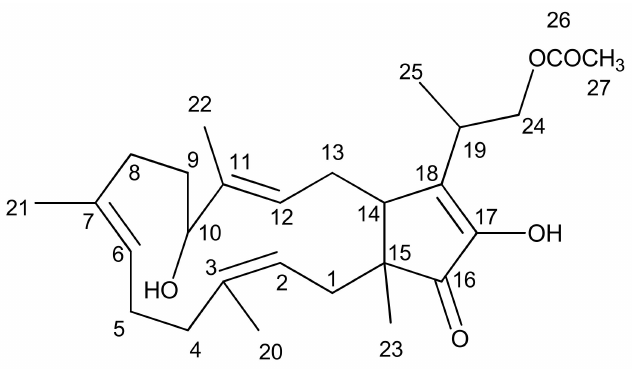
Figure 1. Structure of